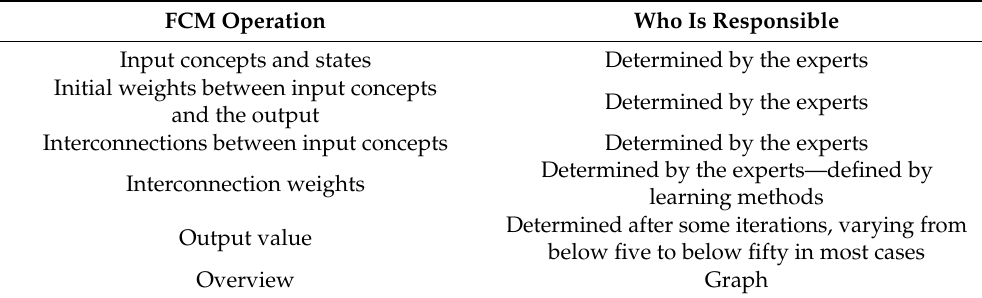
Table 4. Operations of FCMs and the human involvement that ensures a high level of